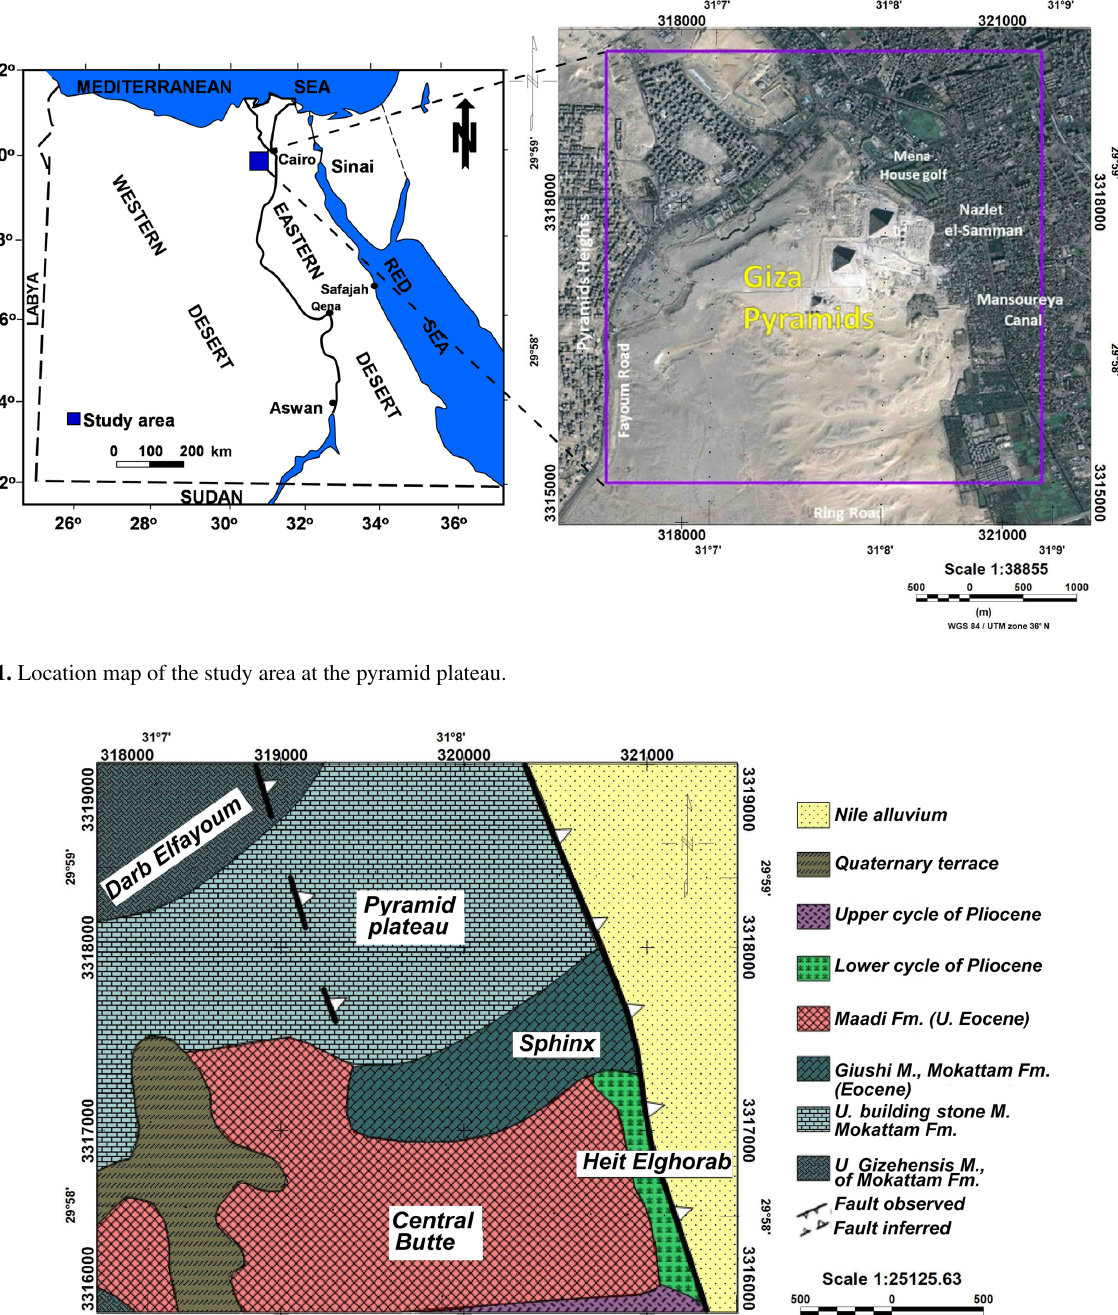
in the GPG are illustrated in Fig.